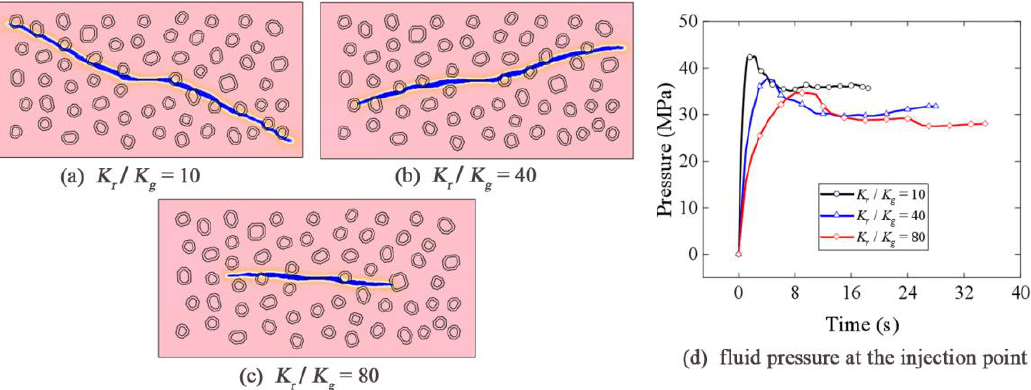
Figure 11. Fracture propagation and fluid pressure at the injection point for